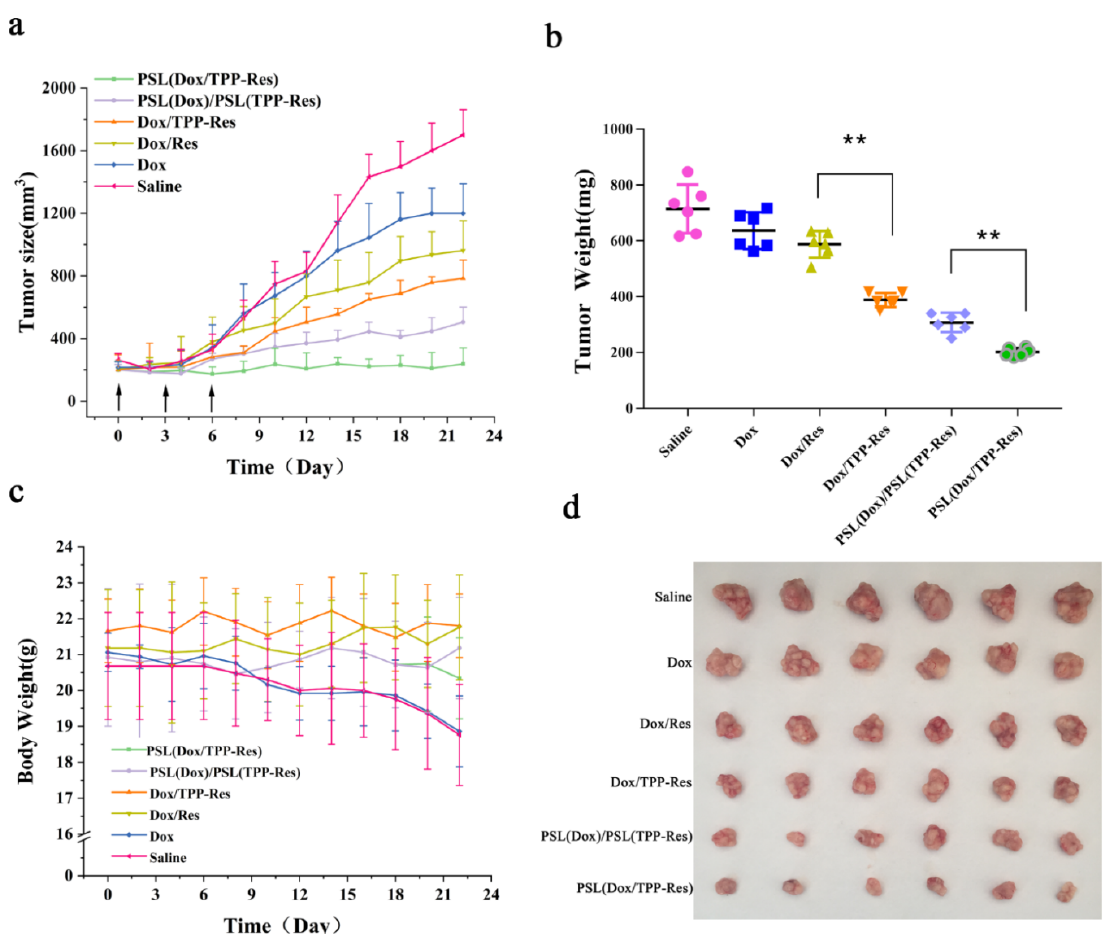
Figure 10. ( a ) Tumor size, ( b ) tumor weight and ( c ) body weight of the CSLCs xenograft tumor-bearing nude mice (n = 6) after intravenous injection with different formulations. ( d ) The images of excised tumor tissues at the time of sacrifice. Data were expressed as mean ± SD (n = 6), ** P < 0.01 compared with the control group.